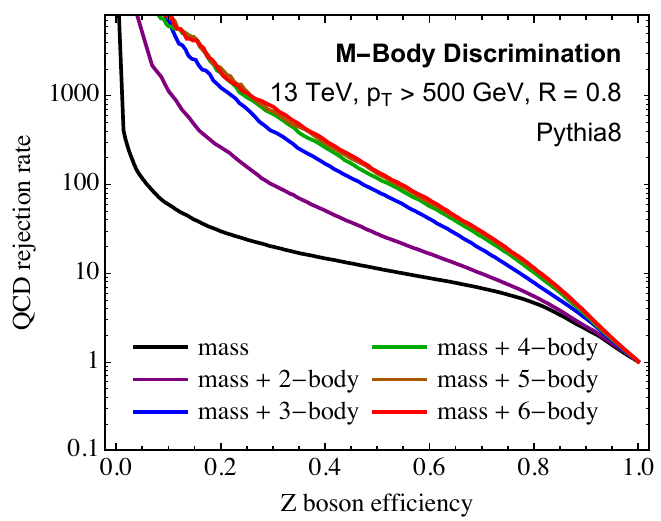
Figure 1. Z boson jet e(cid:14)ciency vs. QCD jet rejection rate plot as generated by the deep neural network. Details of the event simulation, jet (cid:12)nding, and machine learning are described in section 3. The di(cid:11)erent curves correspond to the mass plus collections of observables that uniquely de(cid:12)ne M - body phase space. Discrimination power is seen to saturate when 4-body phase space is